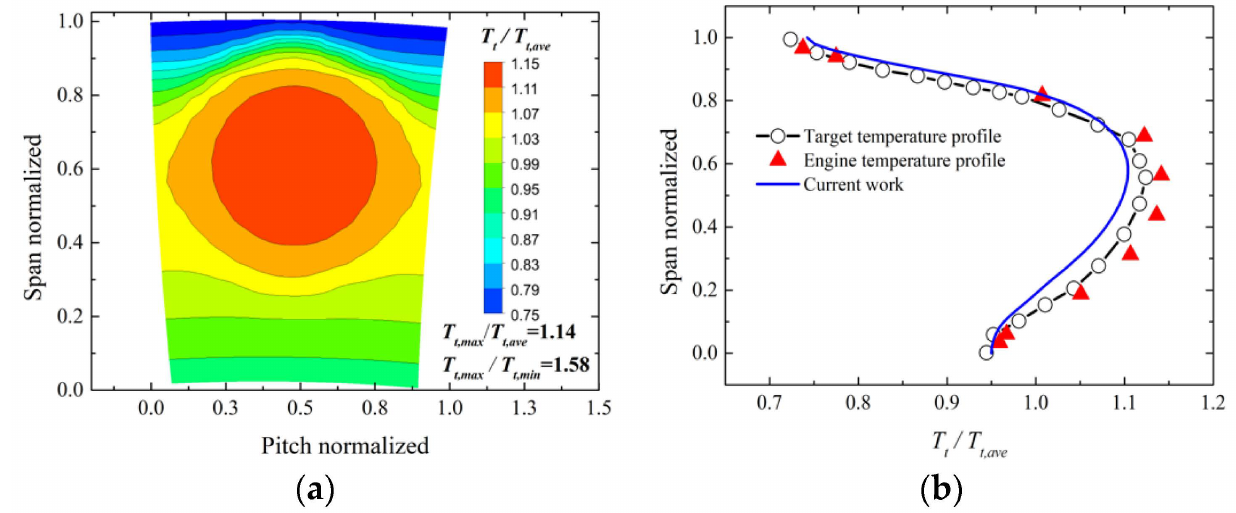
Figure 3. Hot streak at the inlet. ( a ) Total temperature contour. ( b ) Circumferential averaged total temperature